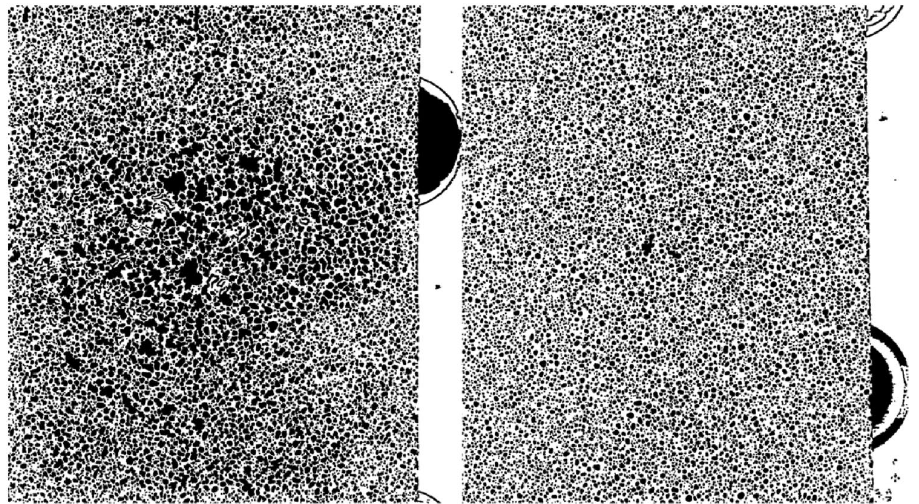
Fig. 12 Exemplary post- processed droplet distribu- tion images obtained by AWT inspection of R-ABS adherend surfaces (25 mm wide, placed on a threaded plate) that had undergone one isopropanol (IPA) wipe-off cleaning step; findings for a region finger- printed beforehand (left) and a pristine region